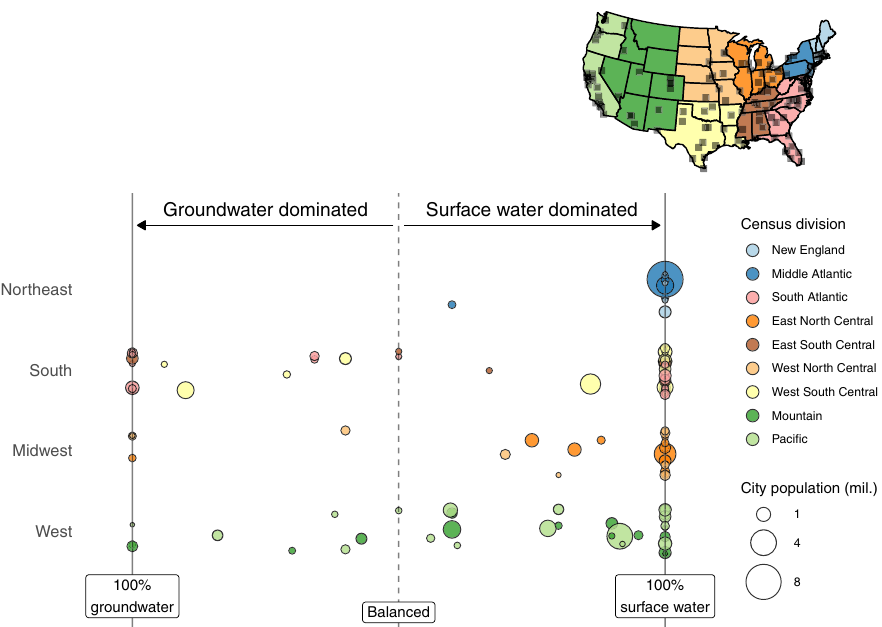
Fig. 1 Surface water dominates urban water supply. Relative contributions of surface water and groundwater to total water supply across 116 United States cities with population exceeding 150,000 people (city locations shown on map, top right). Vertical positioning of each point within each Census region (West/South/Northwest/Midwest) is random to avoid overlap. Table 1 De fi nitions of planned and unplanned forms of wastewater